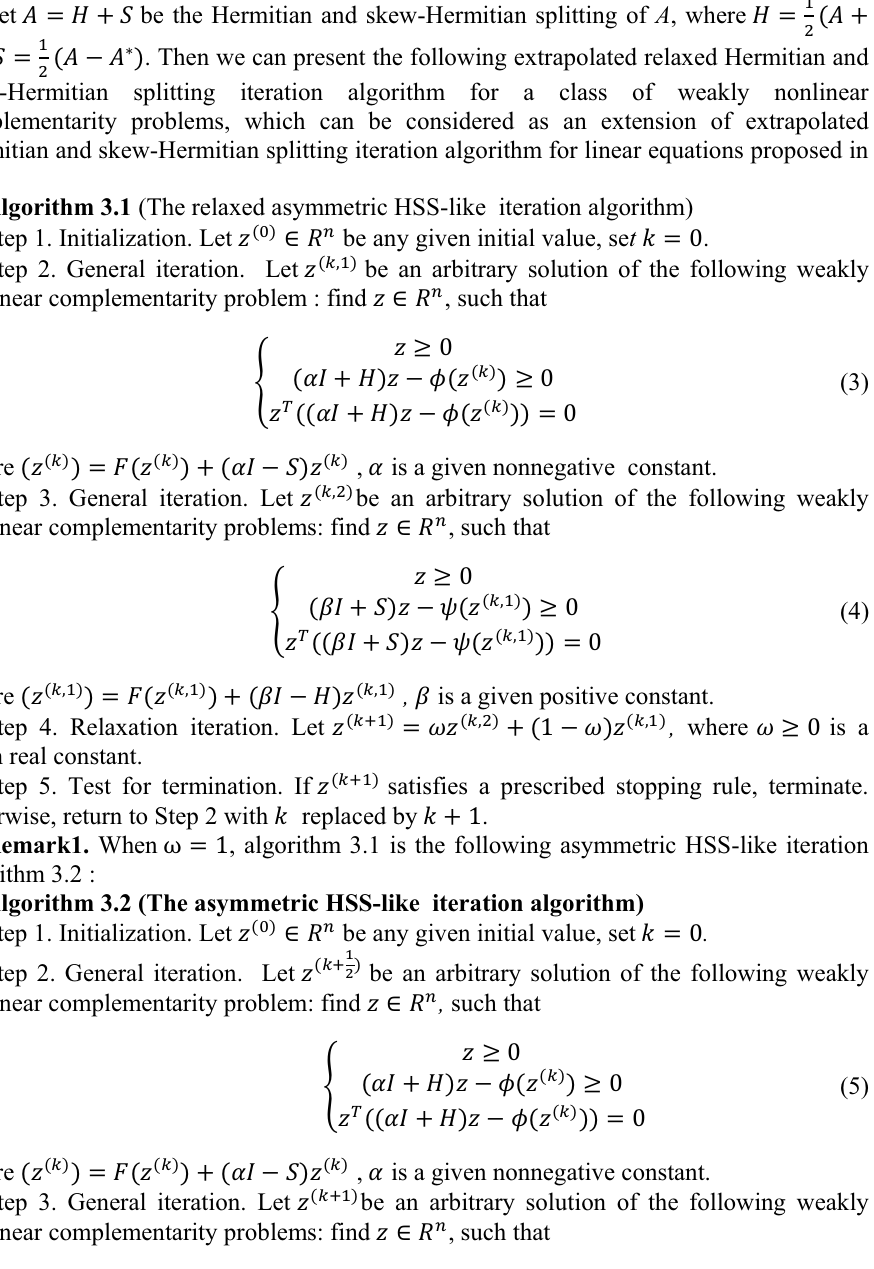
Algorithm 3.1 (The relaxed asymmetric HSS-like iteration algorithm)